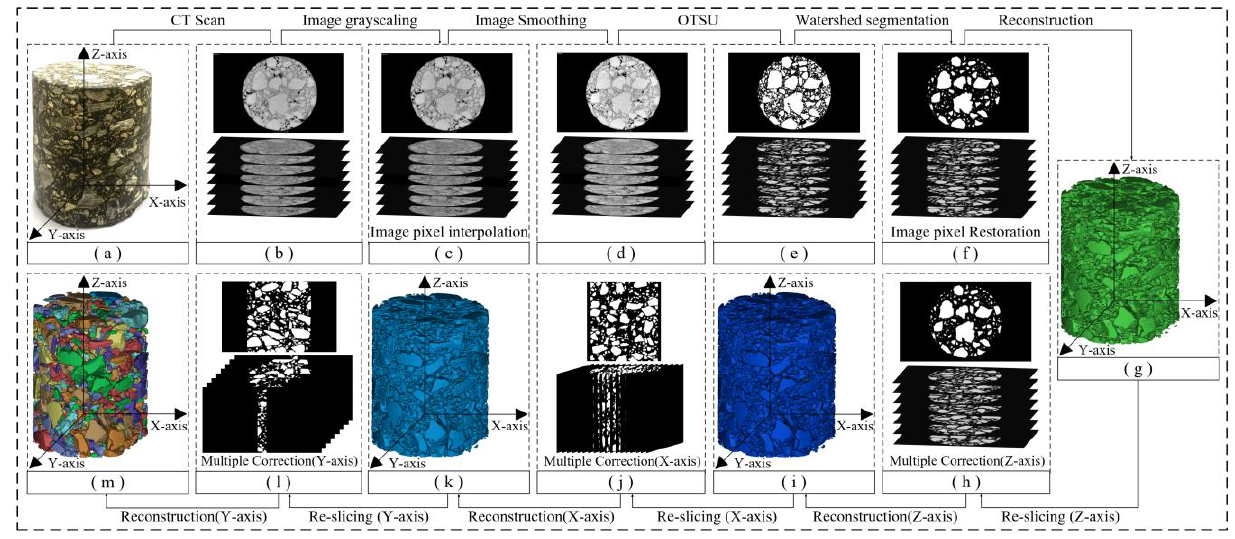
Figure 8. Processing results of each stage of the improved procedure for 3D reconstruction: (a) asphalt concrete specimen; (b) original CT images of asphalt concrete specimen; (c) CT images after grayscaling and pixel interpolation; (d) CT images after smoothing; (e) CT images after the OTSU segmentation; (f) CT images after the watershed segmentation and pixel restoration; (g) Completing the 3D voxel reconstruction; (h) Completing the Z-axis multiple correction; (i) Completing the 3D voxel reconstruction along the Z-axis; (j) Completing the X-axis multiple correction; (k) Completing the 3D voxel reconstruction along the X-axis; (l) Completing the Y-axis multiple correction; (m) Completing the 3D voxel reconstruction along the Y-axis.